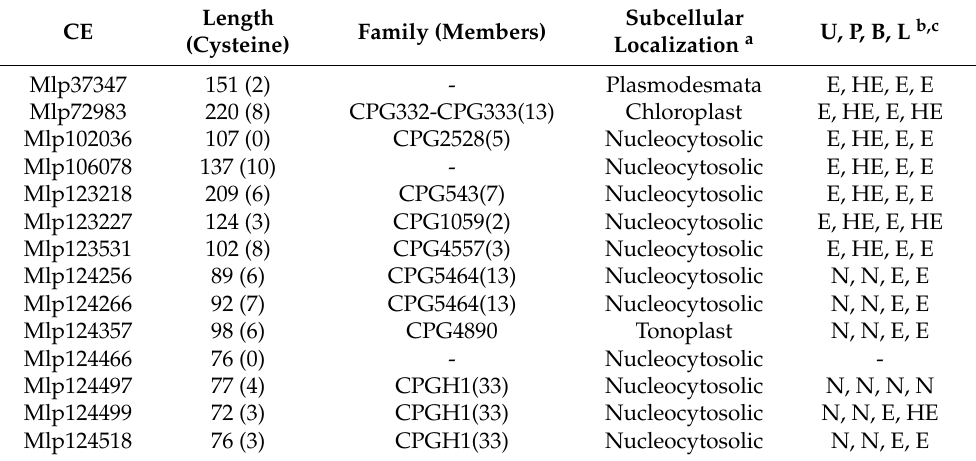
Table 1. Features of the CEs investigated in this